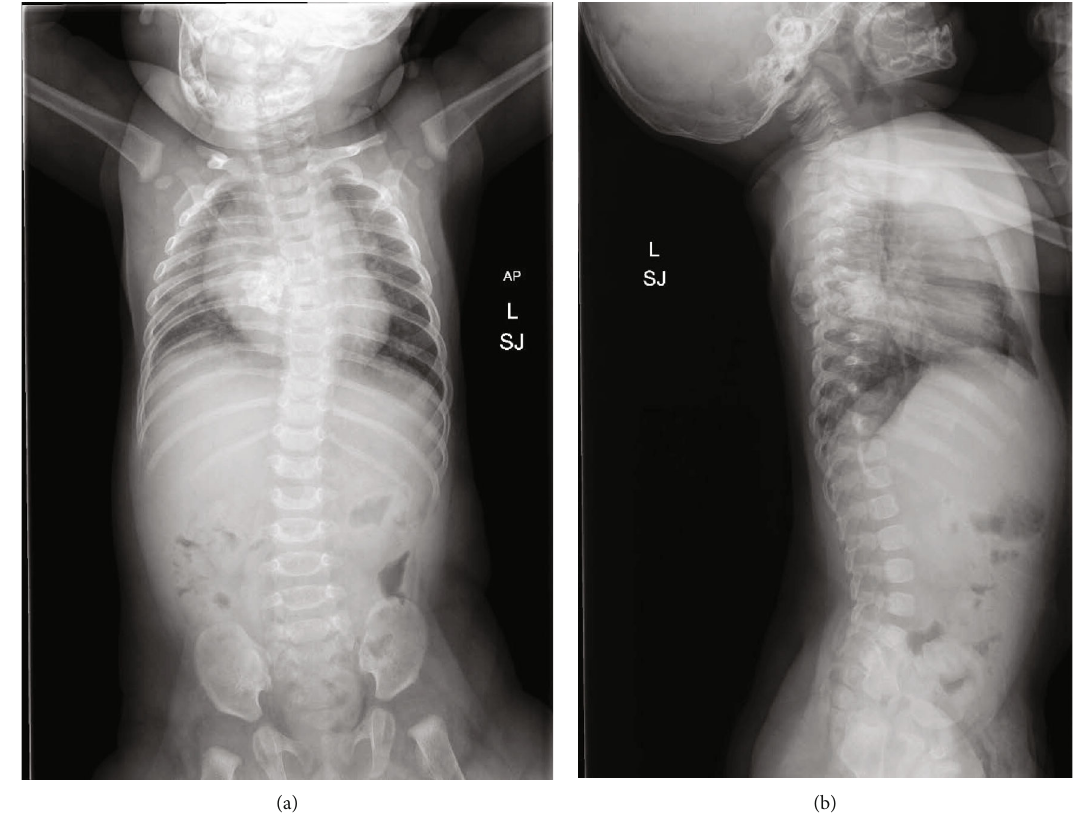
Figure 1: (a) AP spine radiograph showing thoracic levoscoliosis with a calci fi ed lesion projecting from the right posterior aspect of the midthoracic rib segments extending into the soft tissues. (b) Sagittal spine radiograph further demonstrating osseous projection from the midthoracic posterior rib